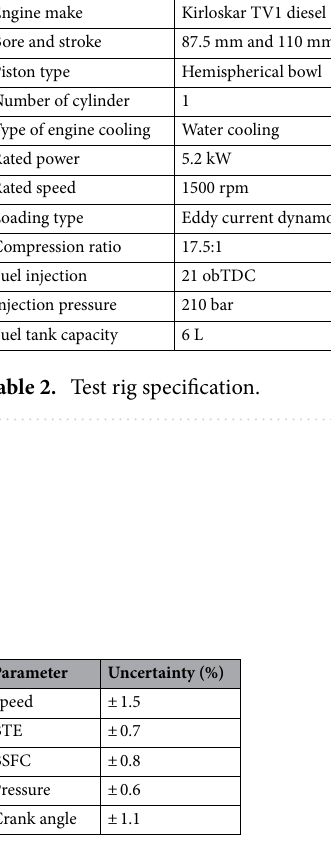
Table 3. Uncertainty of measuring